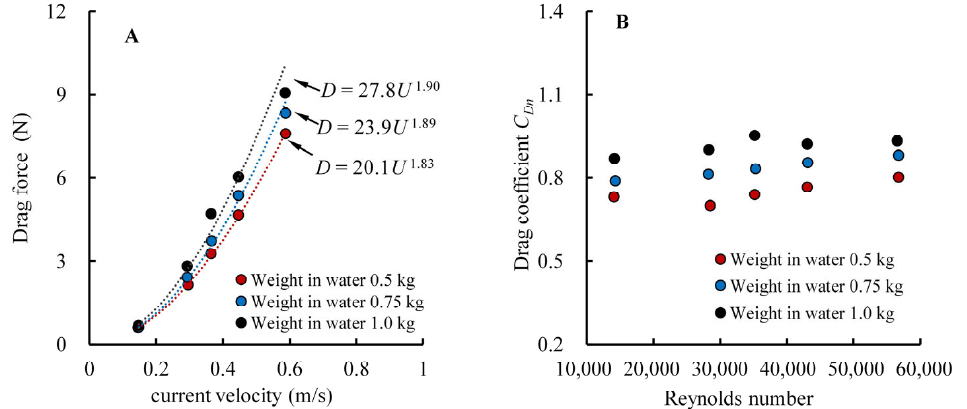
Figure 4. ( A ) Relationship between the drag force and flow velocity of the lantern net model and ( B ) drag coefficient of the lantern net in the Reynolds number range of 1 × 10 4 –1 × 10 6 .